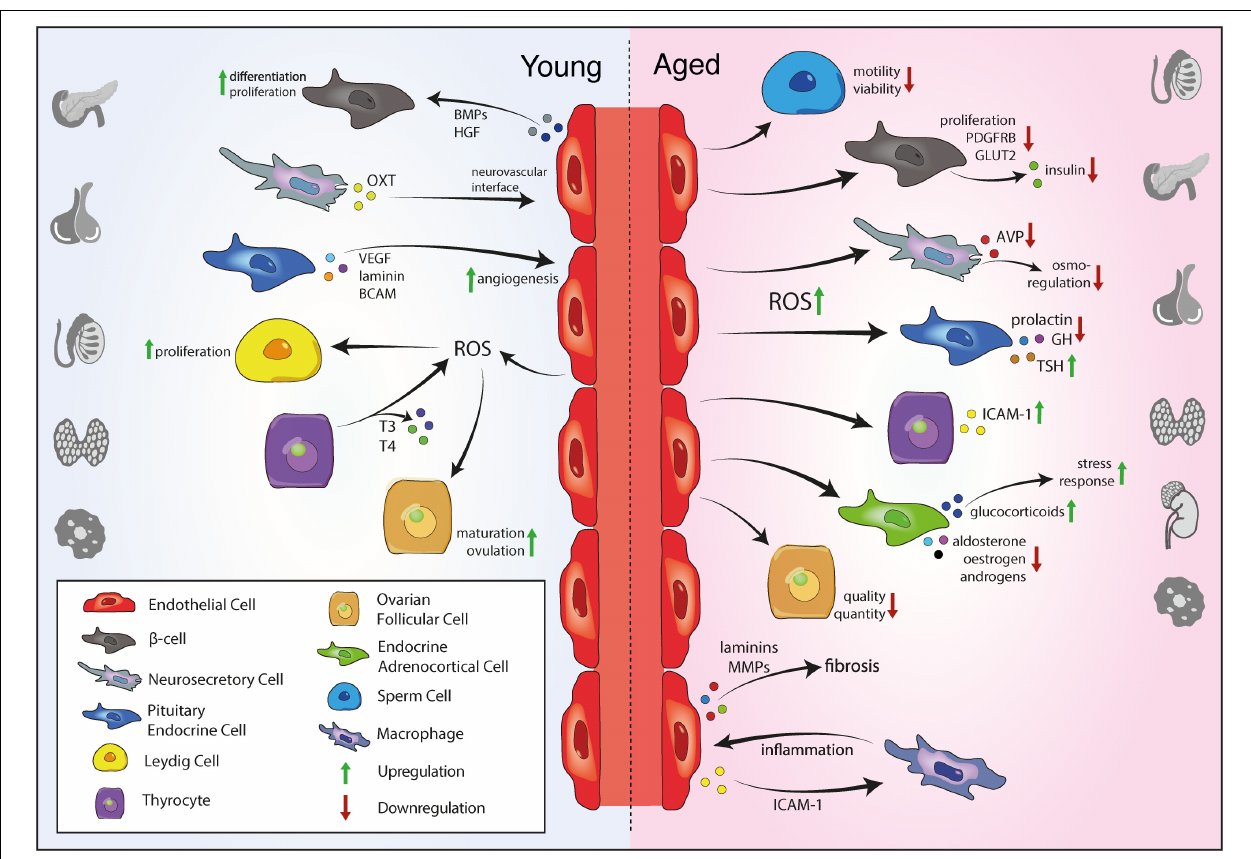
FIGURE 2 | Vascular niche function in the endocrine system during aging. Young ECs secrete angiocrine signals to promote proliferation of endocrine cells and support endocrine function. In the young endocrine system, ECs produce low ROS levels that support Leydig cell proliferation in the testis and promote ovulation OSC maturation in the ovaries. Angiogenic growth factors from pituitary endocrine cells and others promote angiogenesis. Upon aging, endothelial ROS production increases, impairing sperm cell motility, quality and quantity of follicular cells in the ovary and proliferation and hormone production of various endocrine cells, including pancreatic β -cells and endocrine cells and neurosecretory axon terminals in the pituitary gland. In contrast, elevated ROS levels increase the production of inflammatory mediators such ICAM-1 in the thyroid and increases the release of glucocorticoids from the adrenal cortex, promoting the stress response. EC, endothelial cell; ROS, reactive oxygen species; T3, triiodothyronine; T4, thyroxine; VEGF, vascular endothelial growth factor; BCAM, basal cell adhesion molecule; OXT, oxytocin; BMP, bone morphogenetic protein; HGF, hepatocyte growth factor; AVP, arginine vasopressin; GH, growth hormone; TSH, thyroid stimulating hormone; ICAM-1, intercellular adhesion molecule 1; MMP, matrix